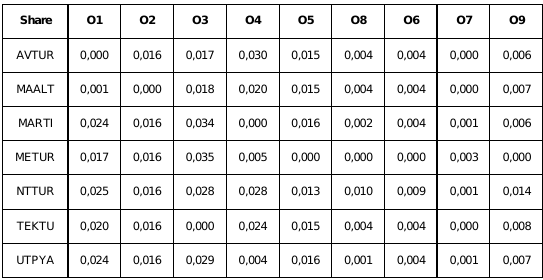
Table 12: 2013 Yearly Positive Ideal Solution Distance